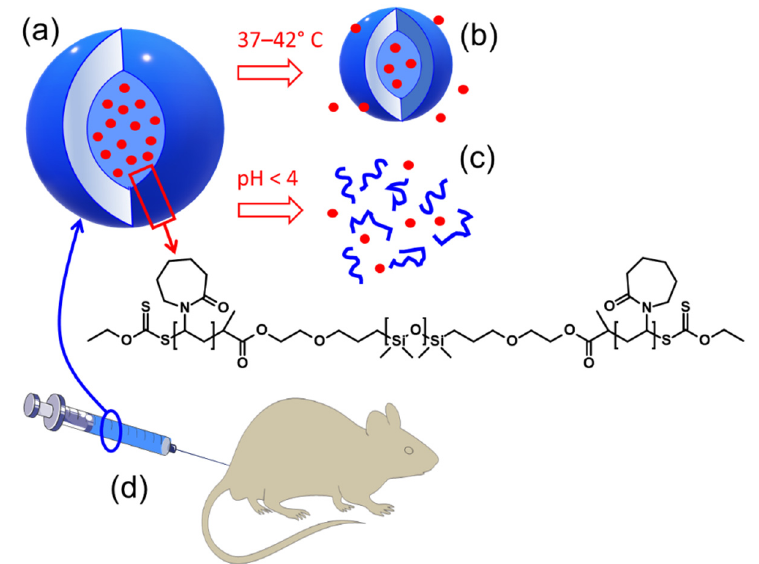
Figure 1. Amphiphilic PVCL 10 -PDMS 65 -PVCL 10 triblock copolymer assembles into polymer vesicles ( a ) at room temperature and encapsulates DOX. The vesicles shrink upon temperature increase ( b ) and dissolve due to degradation of ester links between polymer blocks at acidic pH ( c ) and release the drug. In-vivo cytotoxicity of these block copolymer vesicles was evaluated using a mouse model ( d ).